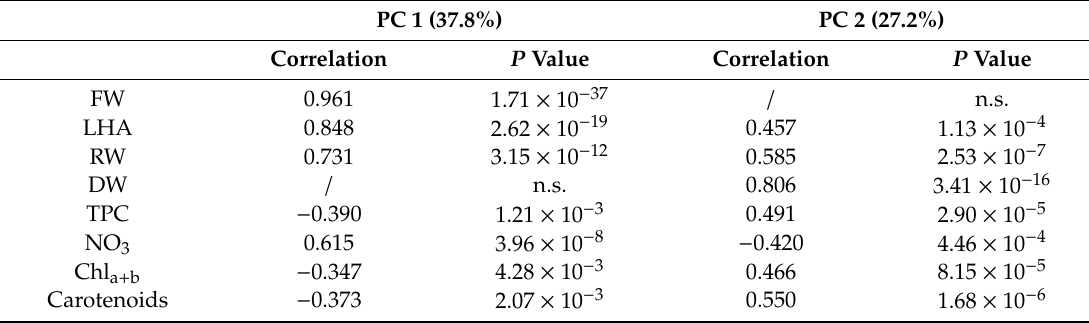
Table 3. Dimension Description of the Lettuce Yield and Quality Variables to PC 1 and PC 2 at the 95% Confidence